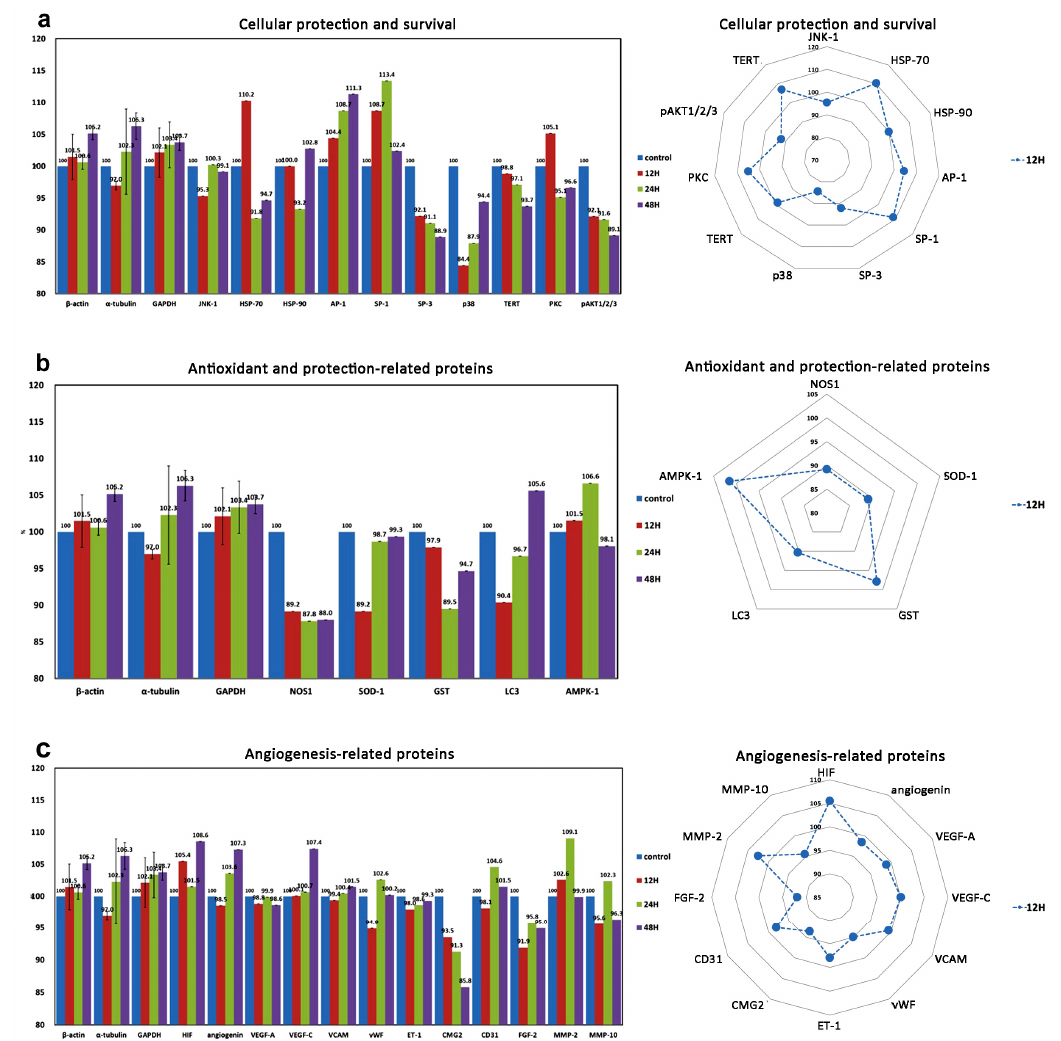
Figure 6. ( a ) Changes to cellular protection and survival-related proteins after PTX treatment in RAW 264.7 cells; ( b ) changes to antioxidant-related proteins after PTX treatment in RAW 264.7 cells; ( c ) changes to angiogenesis-related proteins in after PTX treatment in RAW 264.7 cells. Left-sided graph shows changes to protein expressions according to the application time of PTX, blue bar; control group, red bar; 12 h treatment of PTX, green bar; 24 h treatment of PTX, purple bar; 48 h treatment of PTX. Right-sided polygonal graph shows protein expression profiles after 12 h treatment of